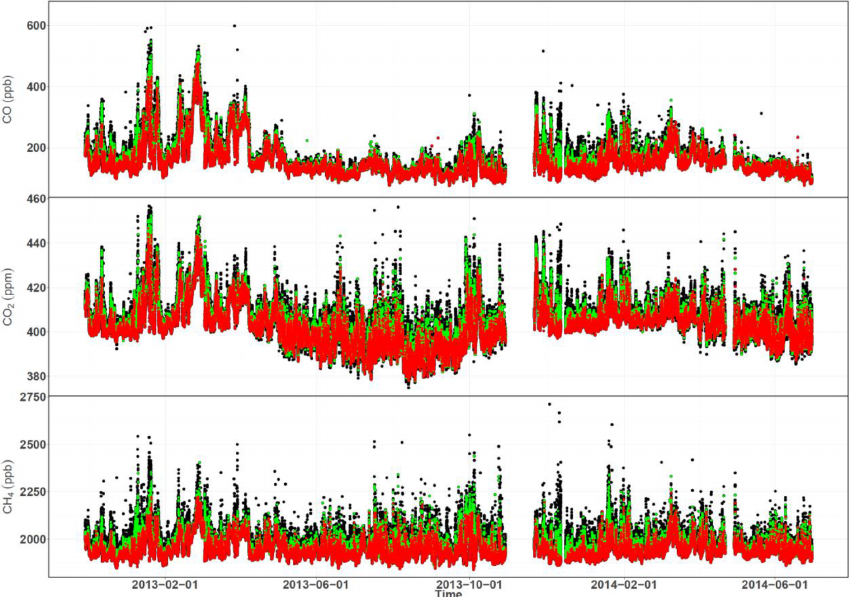
Figure 8. Time series of ambient air measurements at the Beromünster tower at three different height levels: 12.5m (black), 71.5m (green) and 212.5m